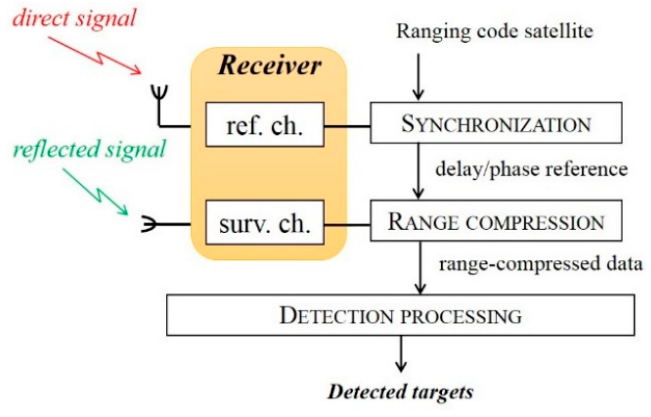
Figure 2. Processing scheme.